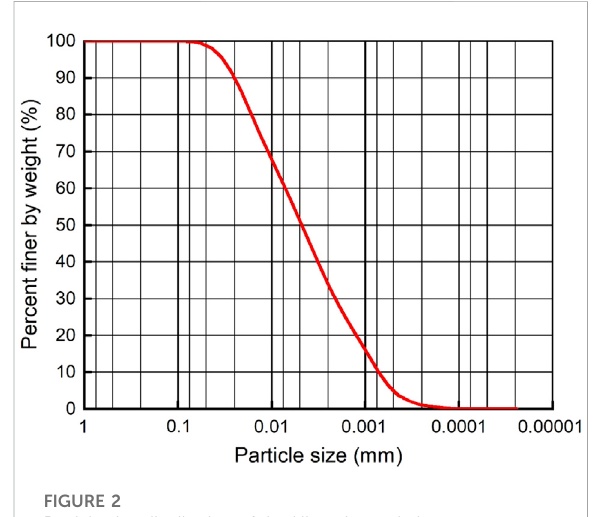
FIGURE 2 Particle size distribution of the Hipparion red clay.